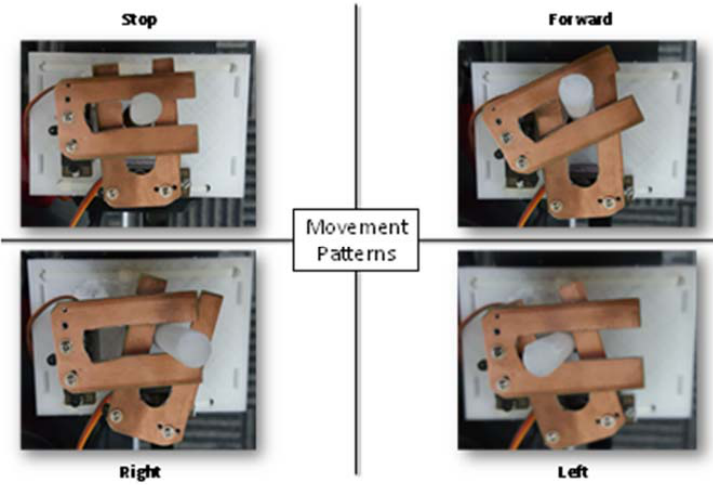
Figure 16. Four di ff erent positions of the servo motors to control four di ff erent classes of the system. Figure 16. Four different positions of the servo motors to control four different classes of the system.